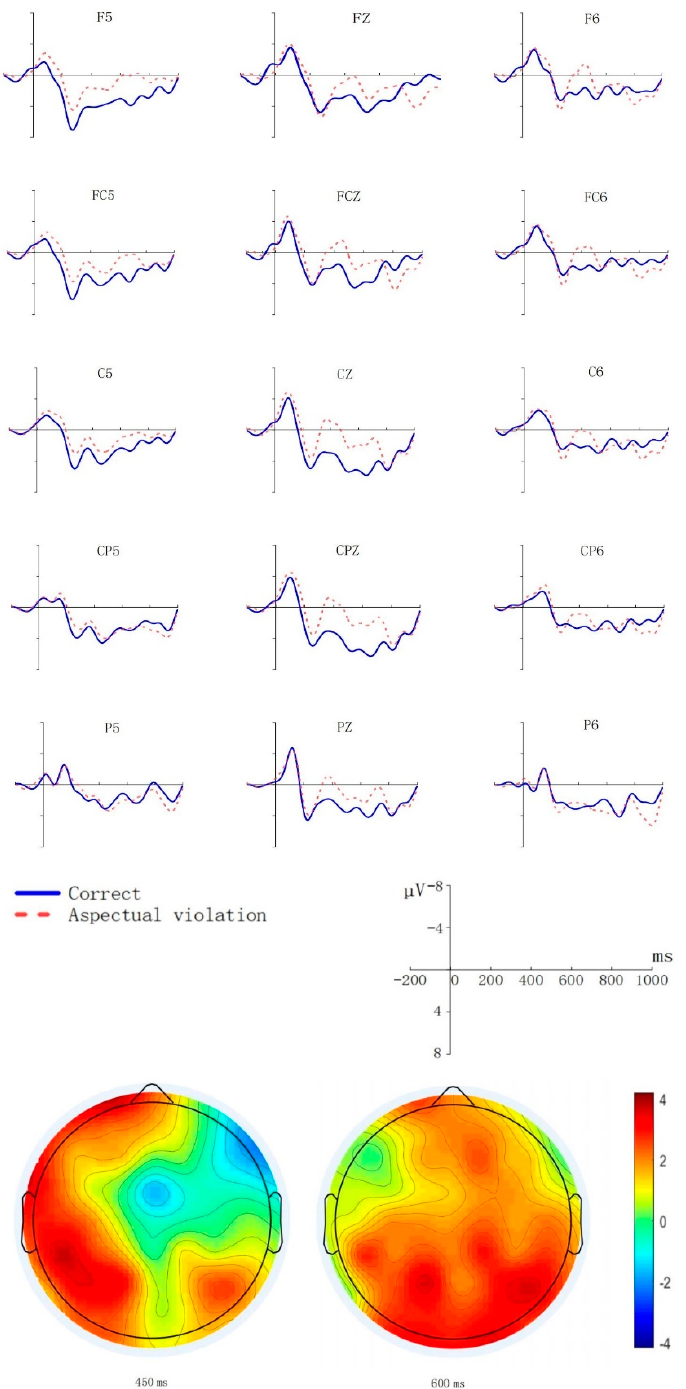
Figure 1. Grand average ( N = 20, with 20 valid samples) ERPs at 15 exemplar electrodes time-locked to the onset (0 ms) of the aspect markers as a function of aspect agreement. The X -axis represents the duration, and each hash mark represents 200 ms. The Y -axis represents the voltage, which ranged from − 8 to +8 µ V. Negativity is plotted upward. The agreement effect’s scalp distribution in the early AN and P600 time windows is also depicted in the topographic maps. The topographical isovoltage map represents the aspect violation effects at 450 ms and 600